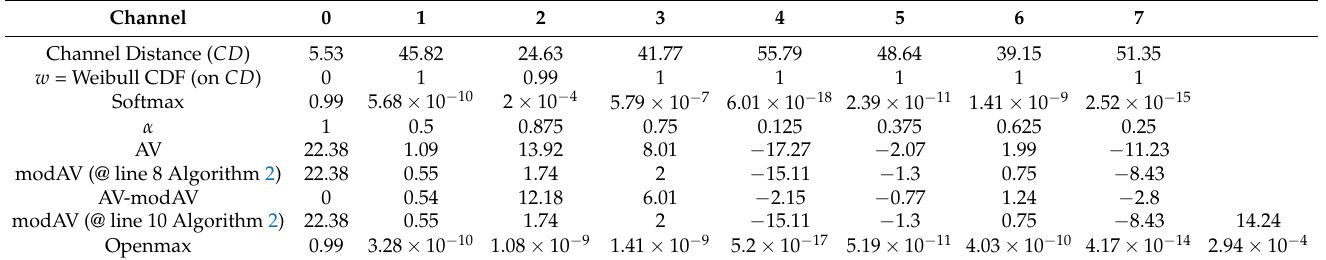
Table 4. Intermediate parameters of the Openmax algorithm given an input image from the class 0. Channel